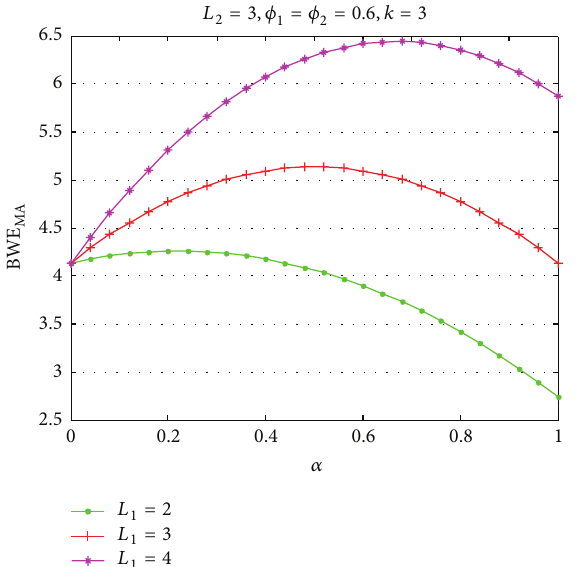
Figure 7: Impact of 𝛼 on bullwhip effect for different 𝐿 1 under the MA.